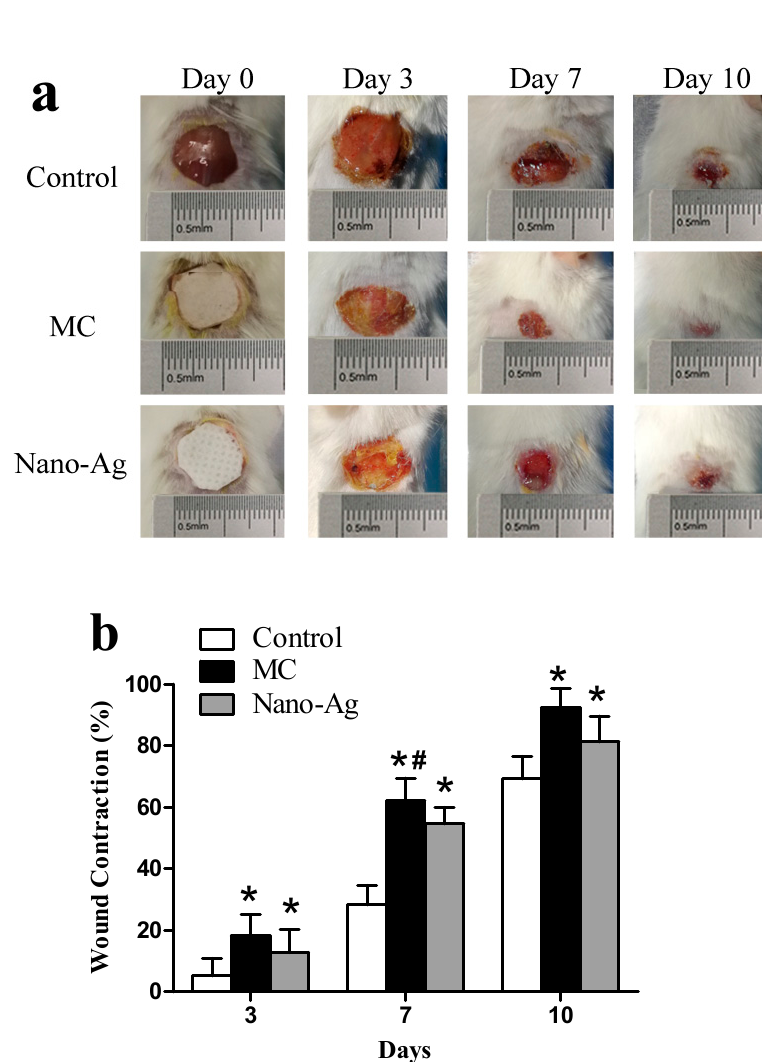
Figure 7. ( a ) Photographic images on days 0, 3, 7, and 10 of wounds treated with sterile gauze (Control group), multilayer composite membranes (MC group), and Nano-Ag dressing (Nano-Ag group). ( b ) Analysis of the wound healing rate in each group on days 3, 7, and 10. * represents a statistically significant di ff erence from the Control group ( p < 0.05). # represents a statistically significant di ff erence from the Nano-Ag group ( p < 0.05).